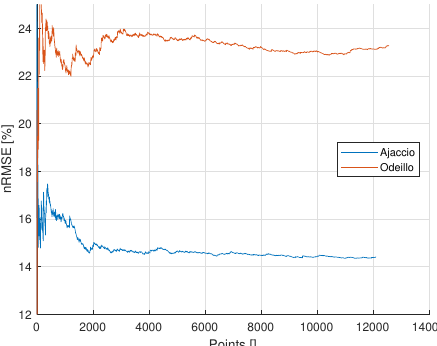
Figure 6. Convergence of the nRMSE for ARMA model versus the number of points taken randomly over the two-year test